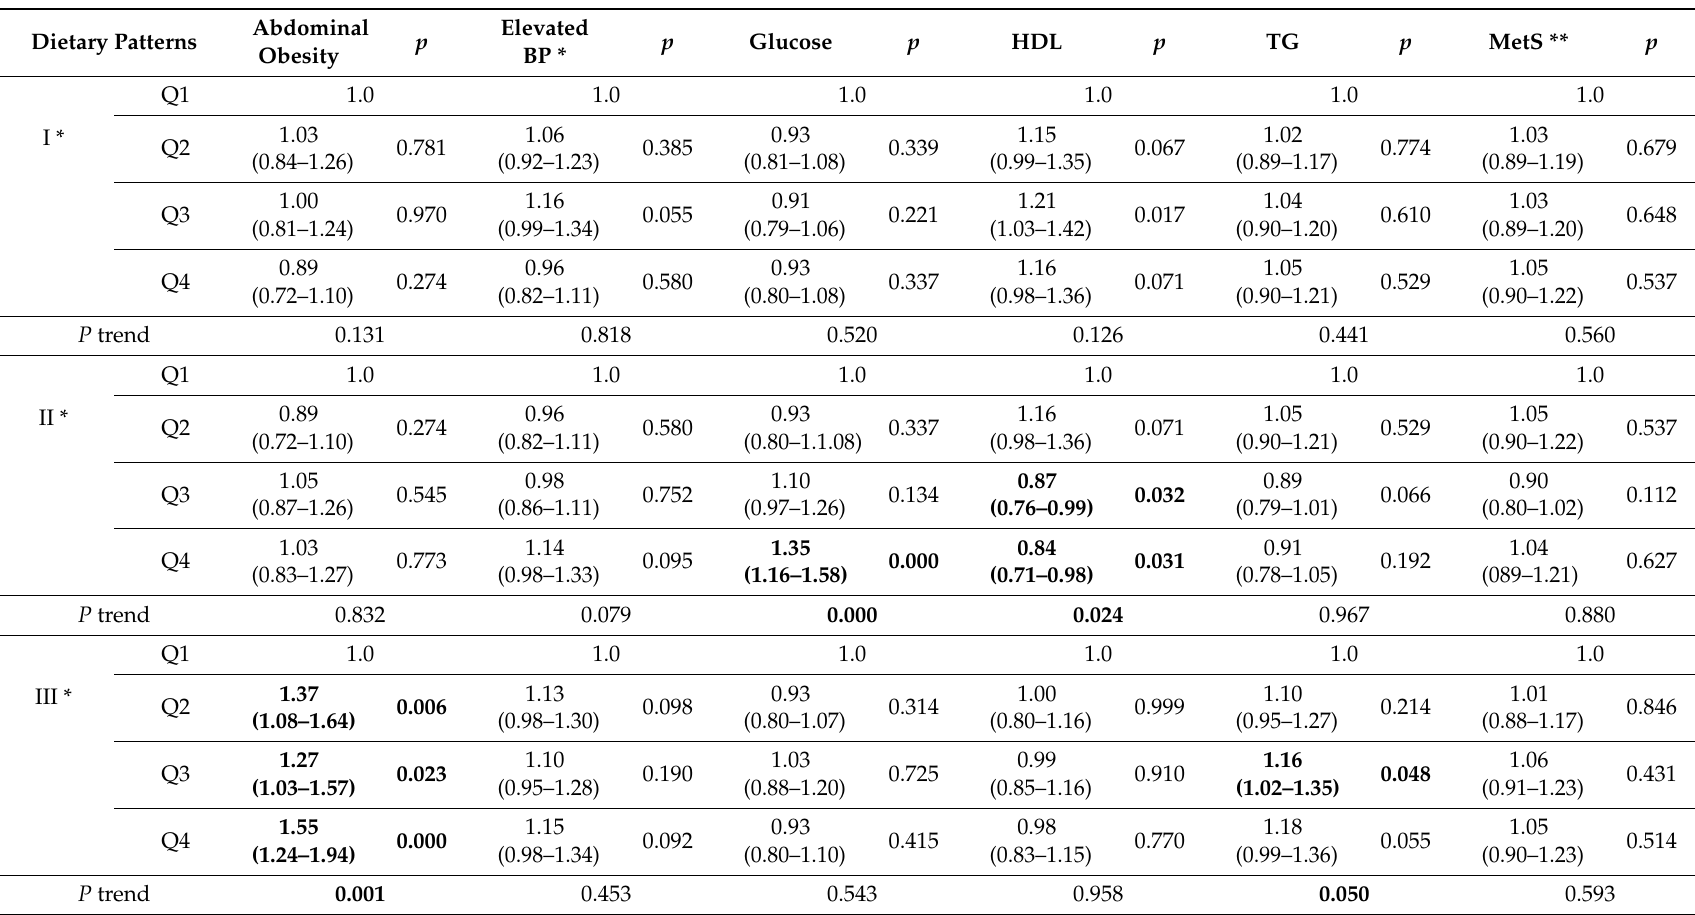
Table 4. Risk (OR) of MetS and its components occurrence in quartile categories of the dietary patterns (Model II adjusted for sex, age, place of living, education, marital status, smoking, physical activity and BMI) (OR; 95%